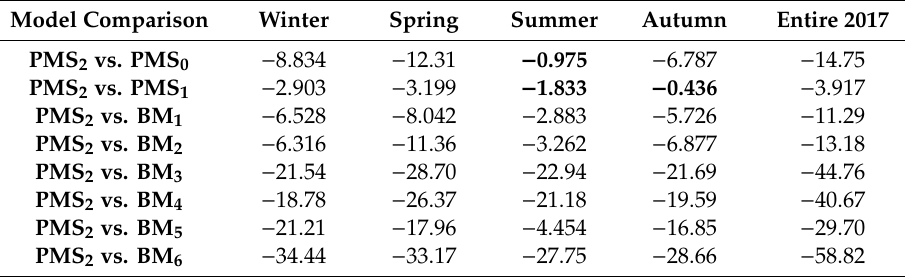
Table 3. DM statistic values of PMS2 against every other